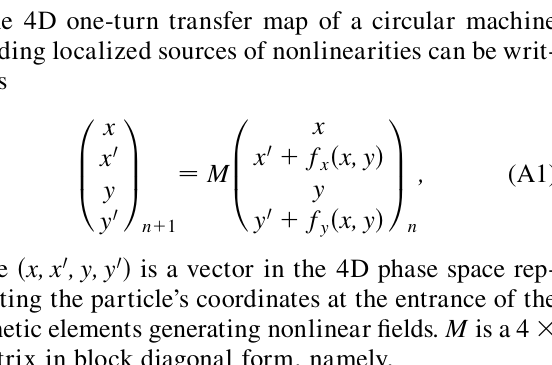
FIG. 11. (Color) Evolution of the main parameters during the multiple multiturn extraction: number of particles (top panel), (cid:14) (center panel), and horizontal tune (bottom panel). The points labeled with letters correspond to the tune values at which the beam distribution is shown in the subsequent Figs. 12 and 13. In this case p (cid:1) 5